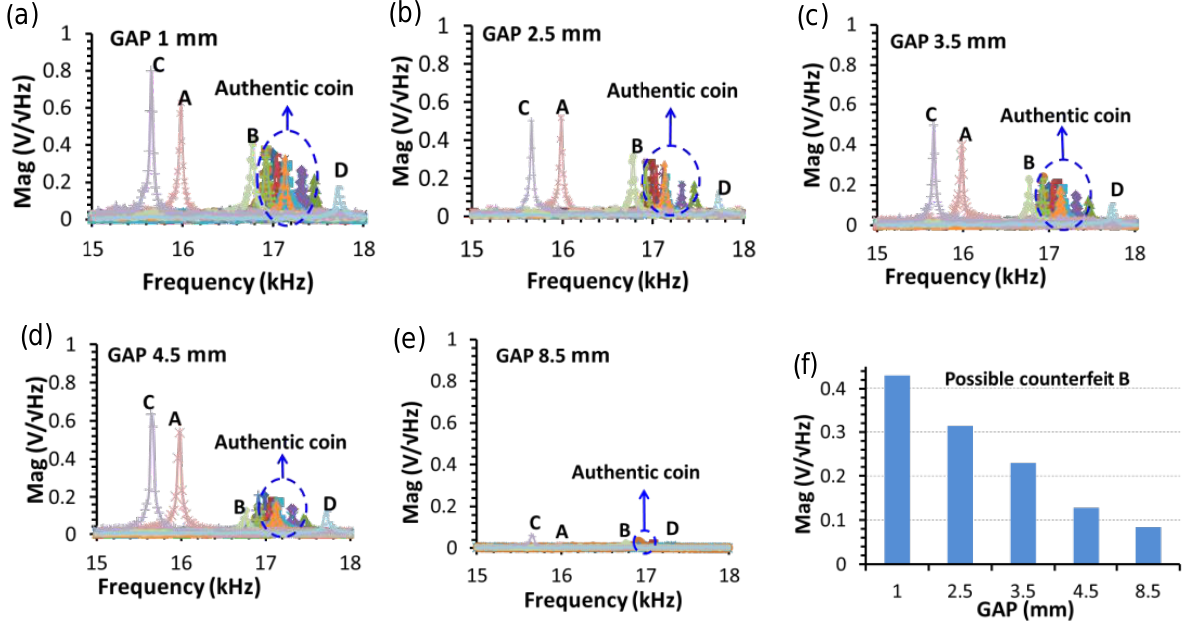
√ Hz at the natural frequency.